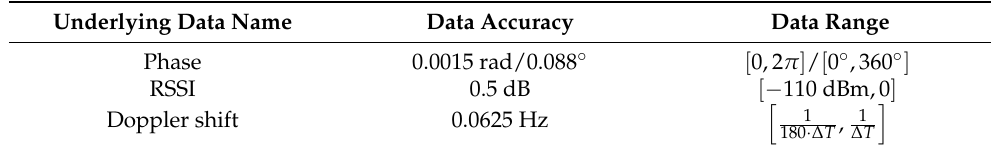
Table 1. Comparison of underlying